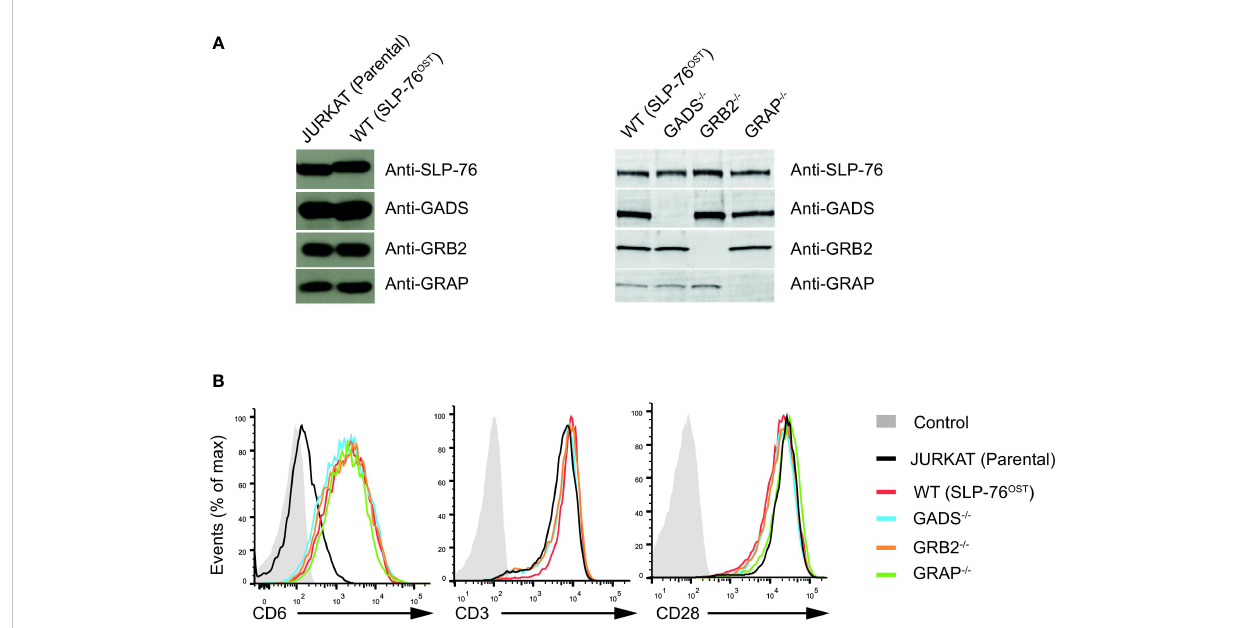
FIGURE 1 Generation and validation SLP76 OST Jurkat cells de fi cient in GRB2-family adaptors. (A) Immunoblot analysis of equal amounts of lysates from parental Jurkat, SLP76 OST (WT), SLP76 OST GADS -/- (GADS -/- ), SLP76 OST GRB2 -/- (GRB2 -/- ) and SLP76 OST GRAP -/- (GRAP -/- ) cells probed with the indicated antibodies. (B) Expression of CD6, CD3 and CD28 at the surface of parental and Jurkat variants indicated in (A) , analyzed using fl ow cytometry. Data are representative of at least three independent